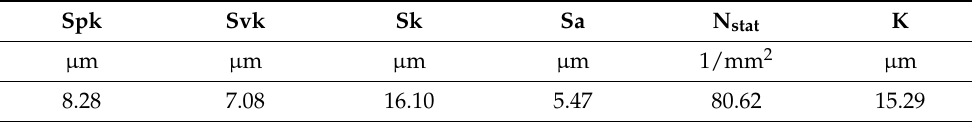
Table 3. Topography characteristics in the initial profiled